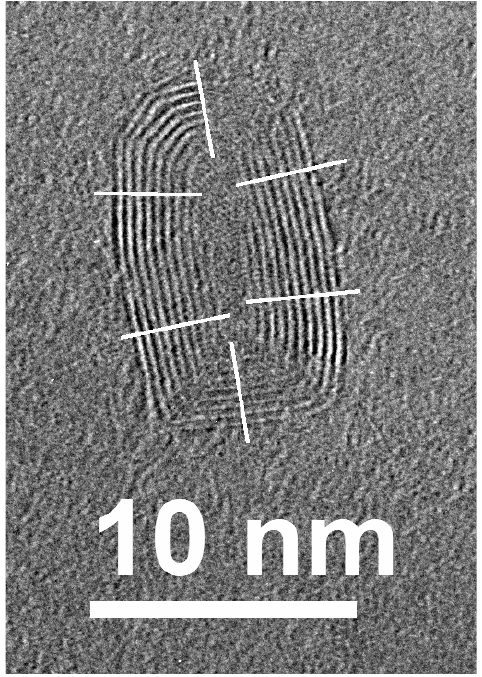
Figure 6. The HRTEM images of a vertical nanotube embedded in the FLG films irradiated with 167 MeV Xe ions at the dose of 5 × 10 11 ion/cm 2 . The interlayer distances were estimated as 0.34–0.35 nm along white lines on the image and 0.19–0.21 nm for the internal nanocrystal part.